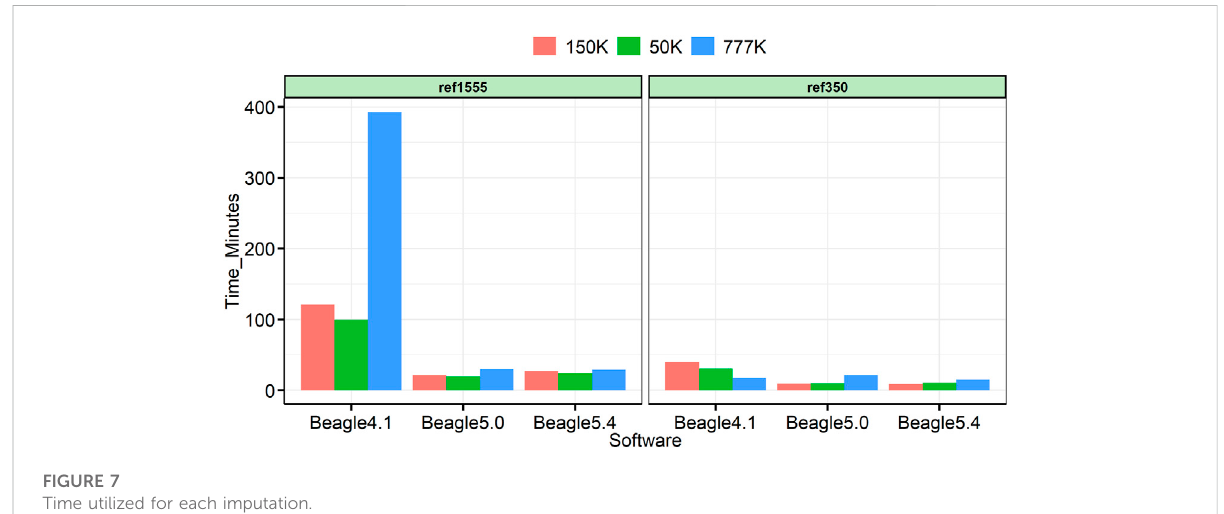
FIGURE 7 Time utilized for each